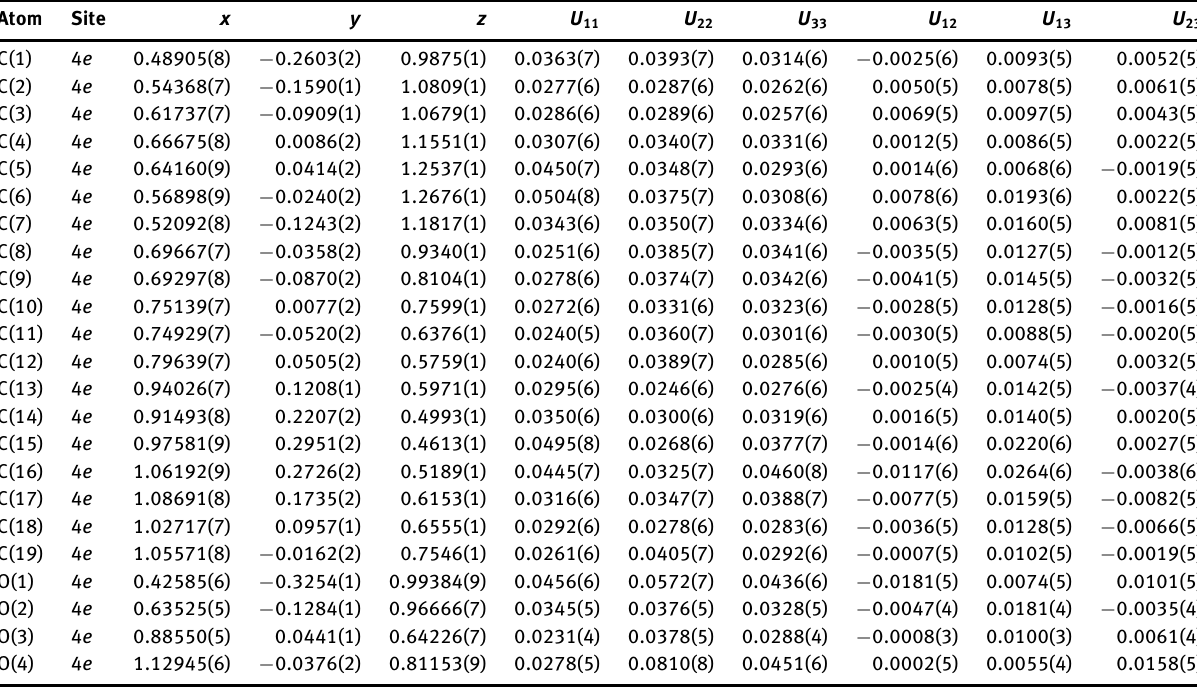
Table 3: Atomic coordinates and displacement parameters (Å 2